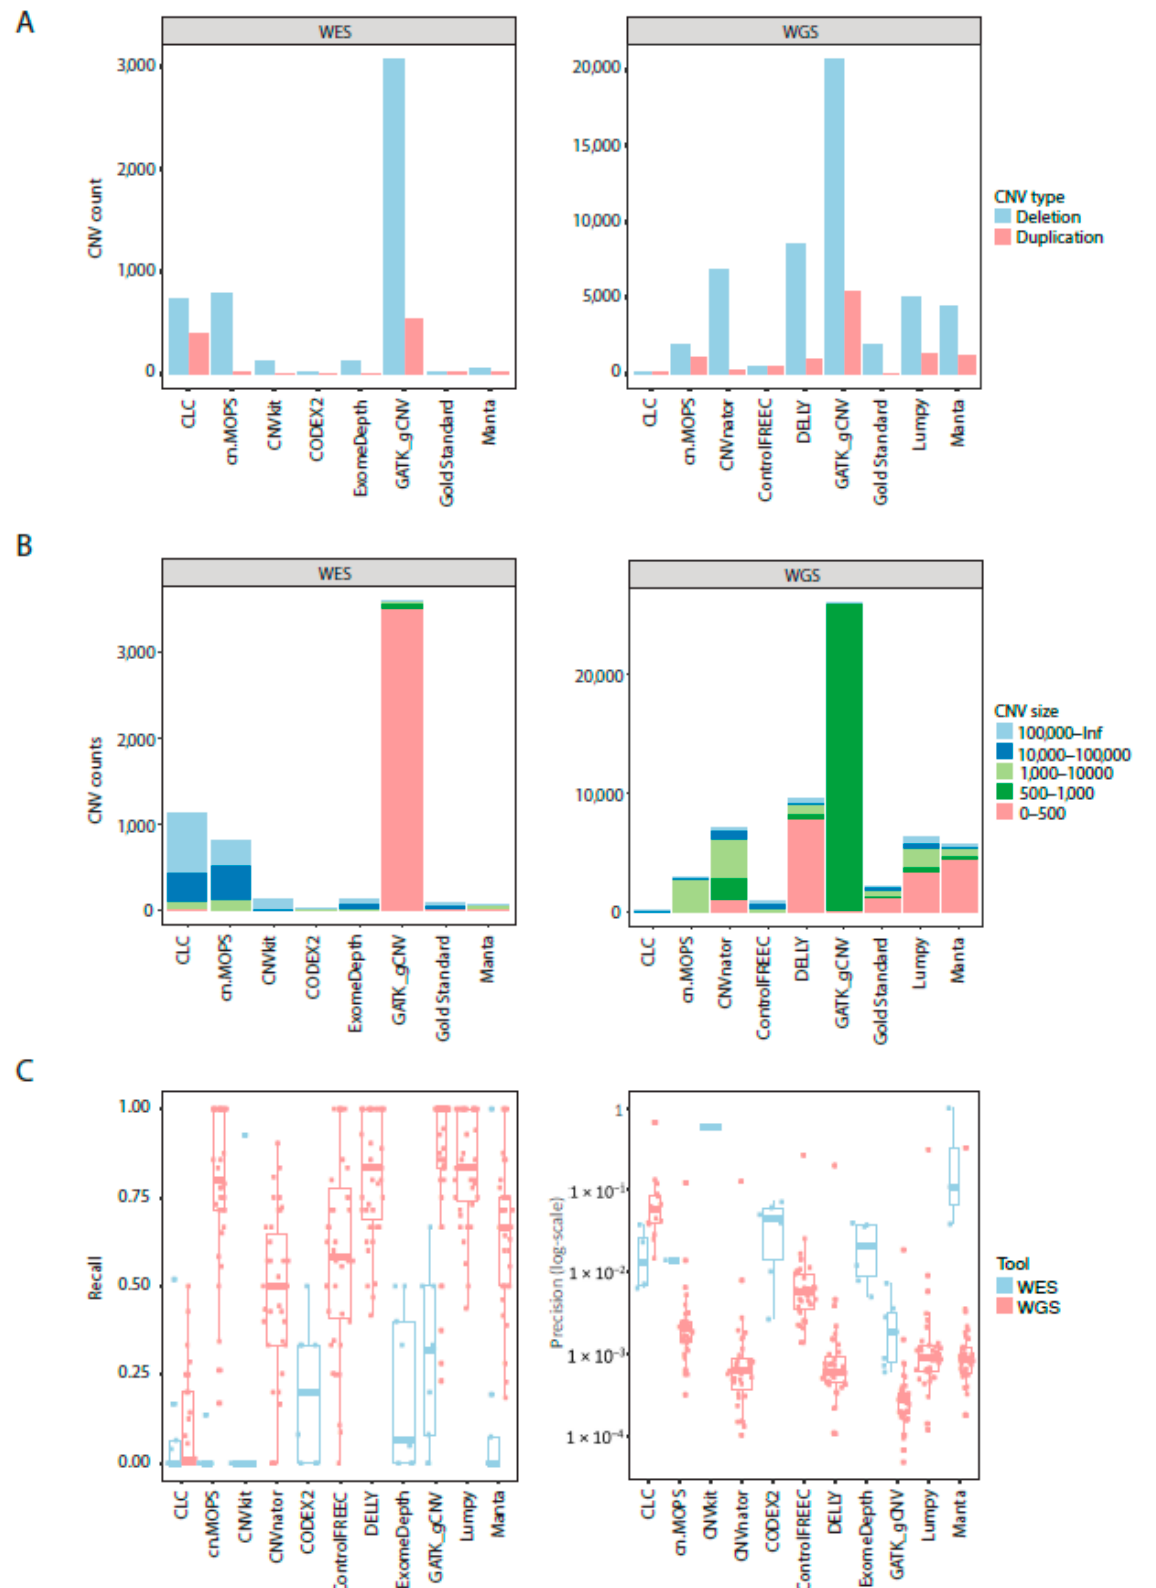
Figure 3. ( A ) Number of duplications and deletions called by CNV calling tools in WES and WGS data for the NA12878 sample. ( B ) Number CNVs called by all tools in WES and WGS data for the NA12878 sample colored by length. ( C ) Box plots and scatter plots for recall and precision results for 11 CNV calling tools.